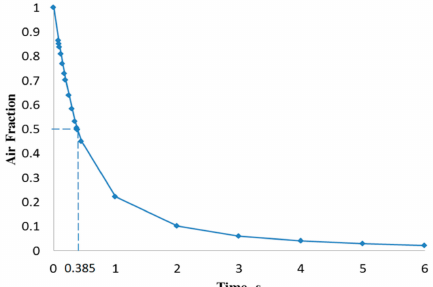
Figure 9. Overall air volume fraction in the chamber vs. filling time at a liquid flow rate of 500 µ L/min.